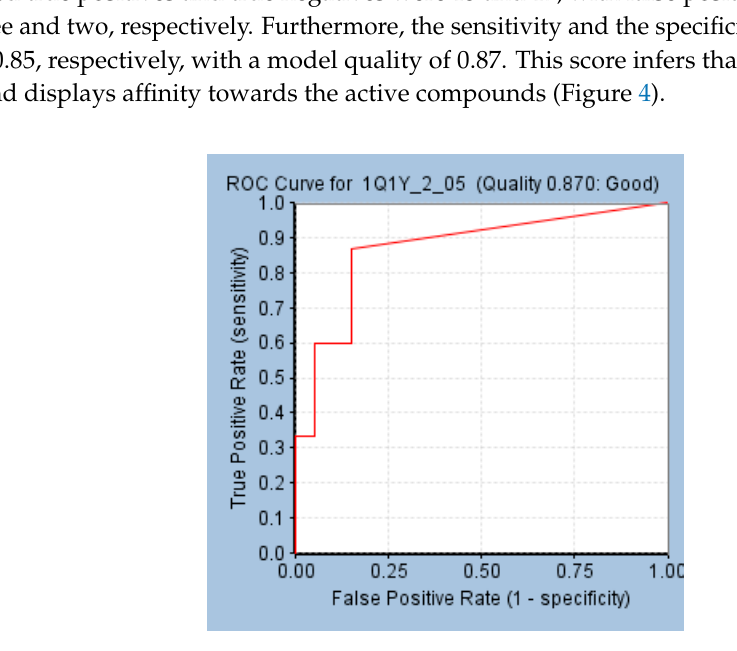
Figure 4. Validation of pharmR employing the receiver operating characteristic curve. Decoy Set Method of Validation for PharmL and